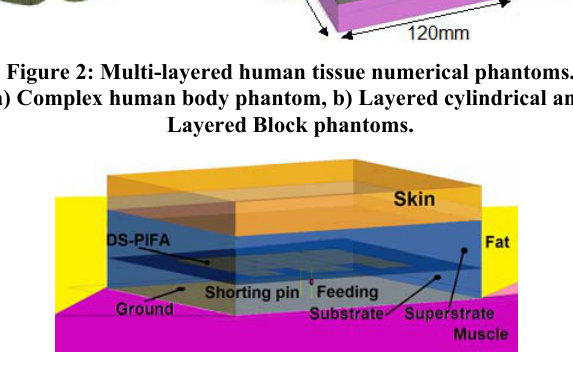
Figure 3: 3D view in Numerical Multilayered Tissue Mimicking phantom.